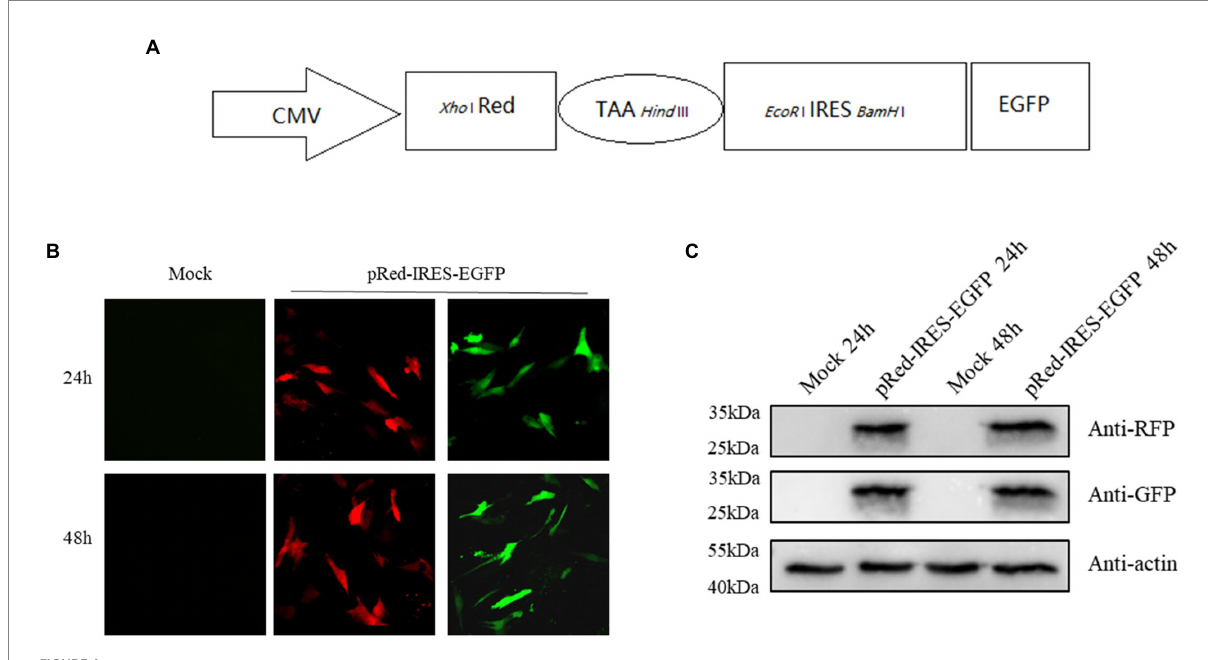
FIGURE 4 The DHAV-1 5 ′ UTR 300–618 nt sequence initiates downstream gene expression. (A) Schematic representation showing the bicistronic vector pRed- IRES-EGFP. (B) DEFs were transfected with plasmids, and green fluorescence and red fluorescence were observed under a microscope 24 and 48 h after transfection. (C) The cells were harvested 24 and 48 h after transfection, and immunoblot analyses were performed with the indicated